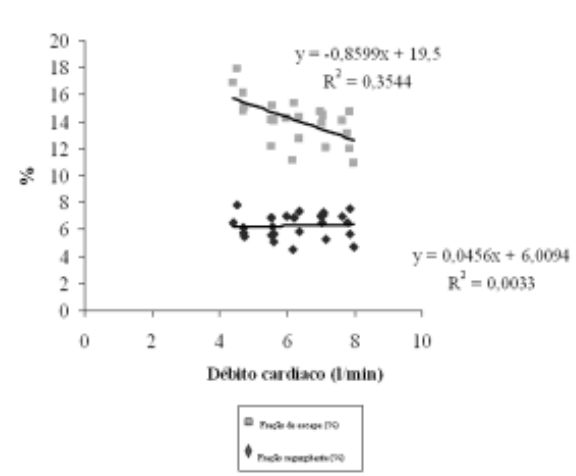
Fig. 4 – Análise da fração regurgitante e da fração de escape.